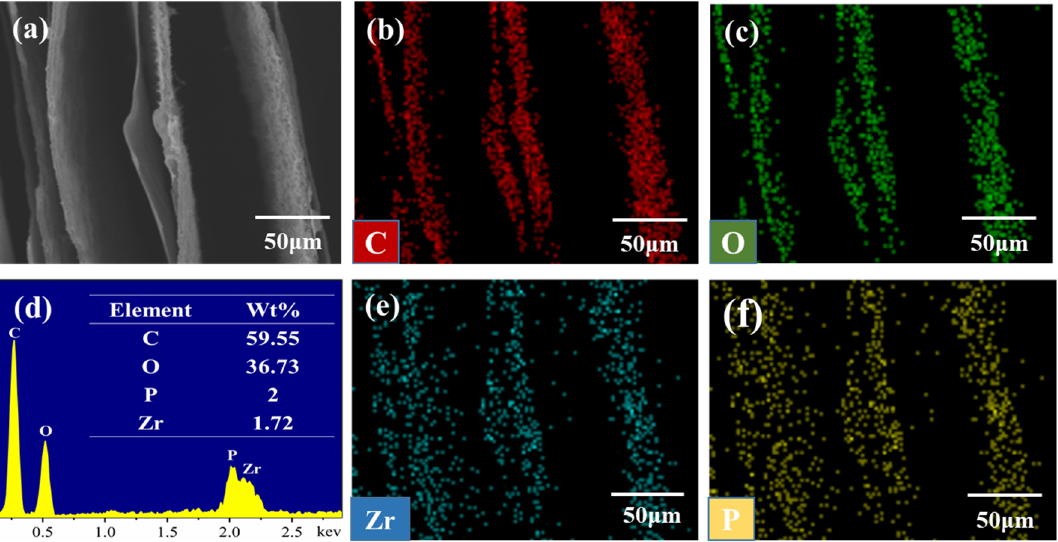
Figure 4. ( a ) SEM image; elemental mapping of PVA/PCF 10 / α -ZrP 10 : ( b ) carbon (C), ( c ) oxygen (O), ( d ) EDS spectra and content, ( e ) zirconium (Zr), and ( f ) phosphorus (P).